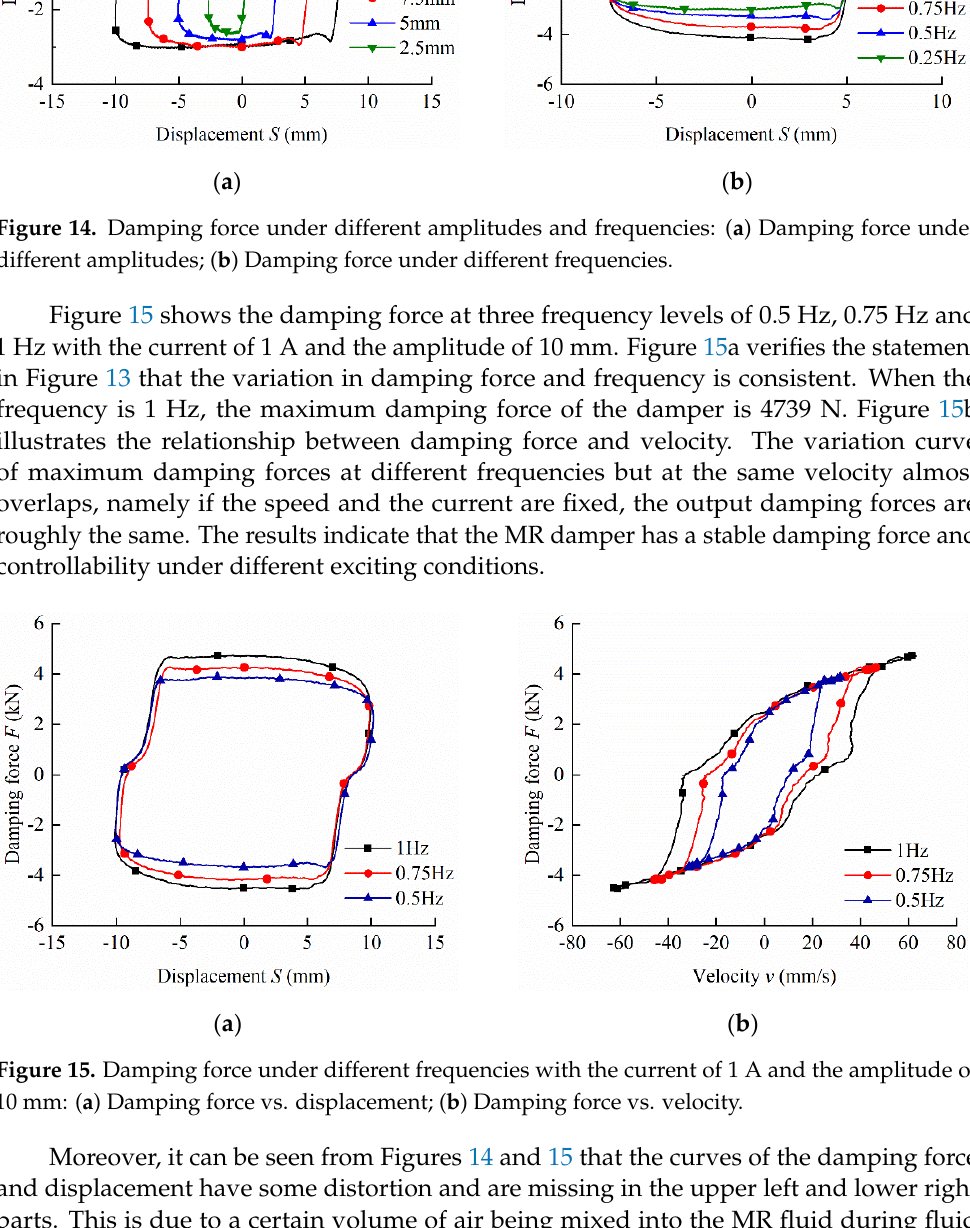
Figure 16. Damping force under different applied currents. As shown in Figure 17, the simulation and experimental results under different currents were compared to verify the feasibility of the established damping force model. The variation curve of the simulated damping force with current is approximately linear while the linear relationship is not obvious in the experiments. The difference between the model and the experiment was caused by the errors of manufacturing and experi- ment, and the established model cannot represent the small change in pressure drop. The maximum error is 366 N when the current is 1 A. However, the errors are within the al- lowable range, and the growth trend of the damping force predicted by the established model is almost the same as measured in the experiments. The damping force of the ex-